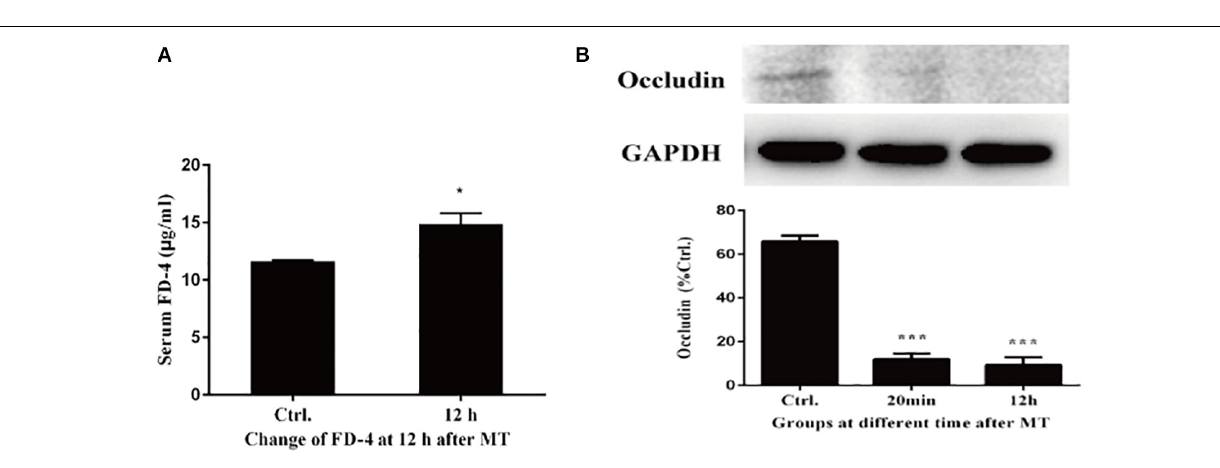
there may be other tissues, D-lactate and LPS were used